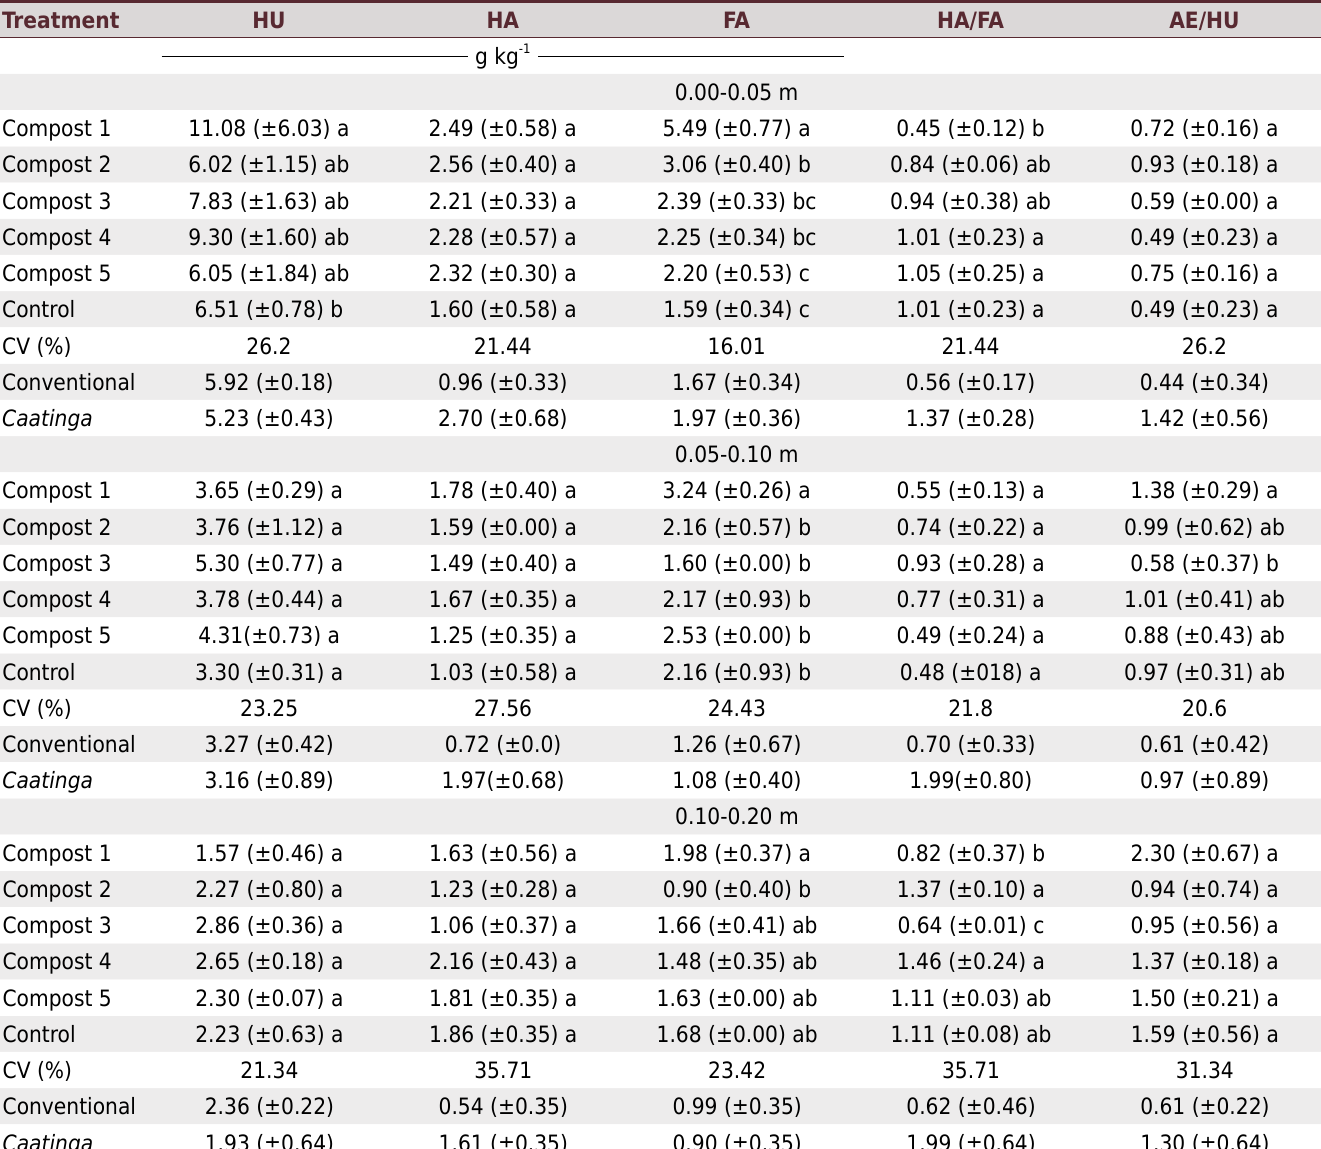
Table 4. Carbon in soil humic fractions and the relationship between fractions of soil fertilized with organic composts and of reference areas Treatment